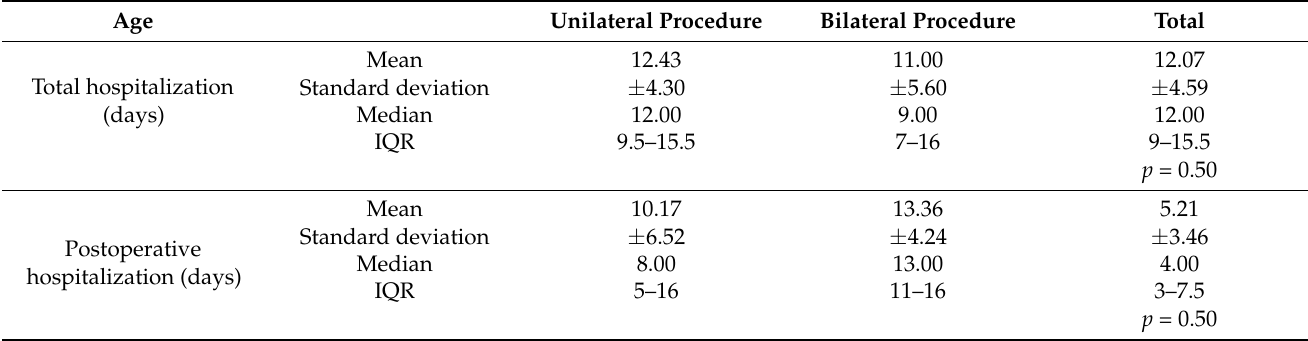
Table 5. Total and postoperative hospitalisation of patients who received unilateral compared to a bilateral